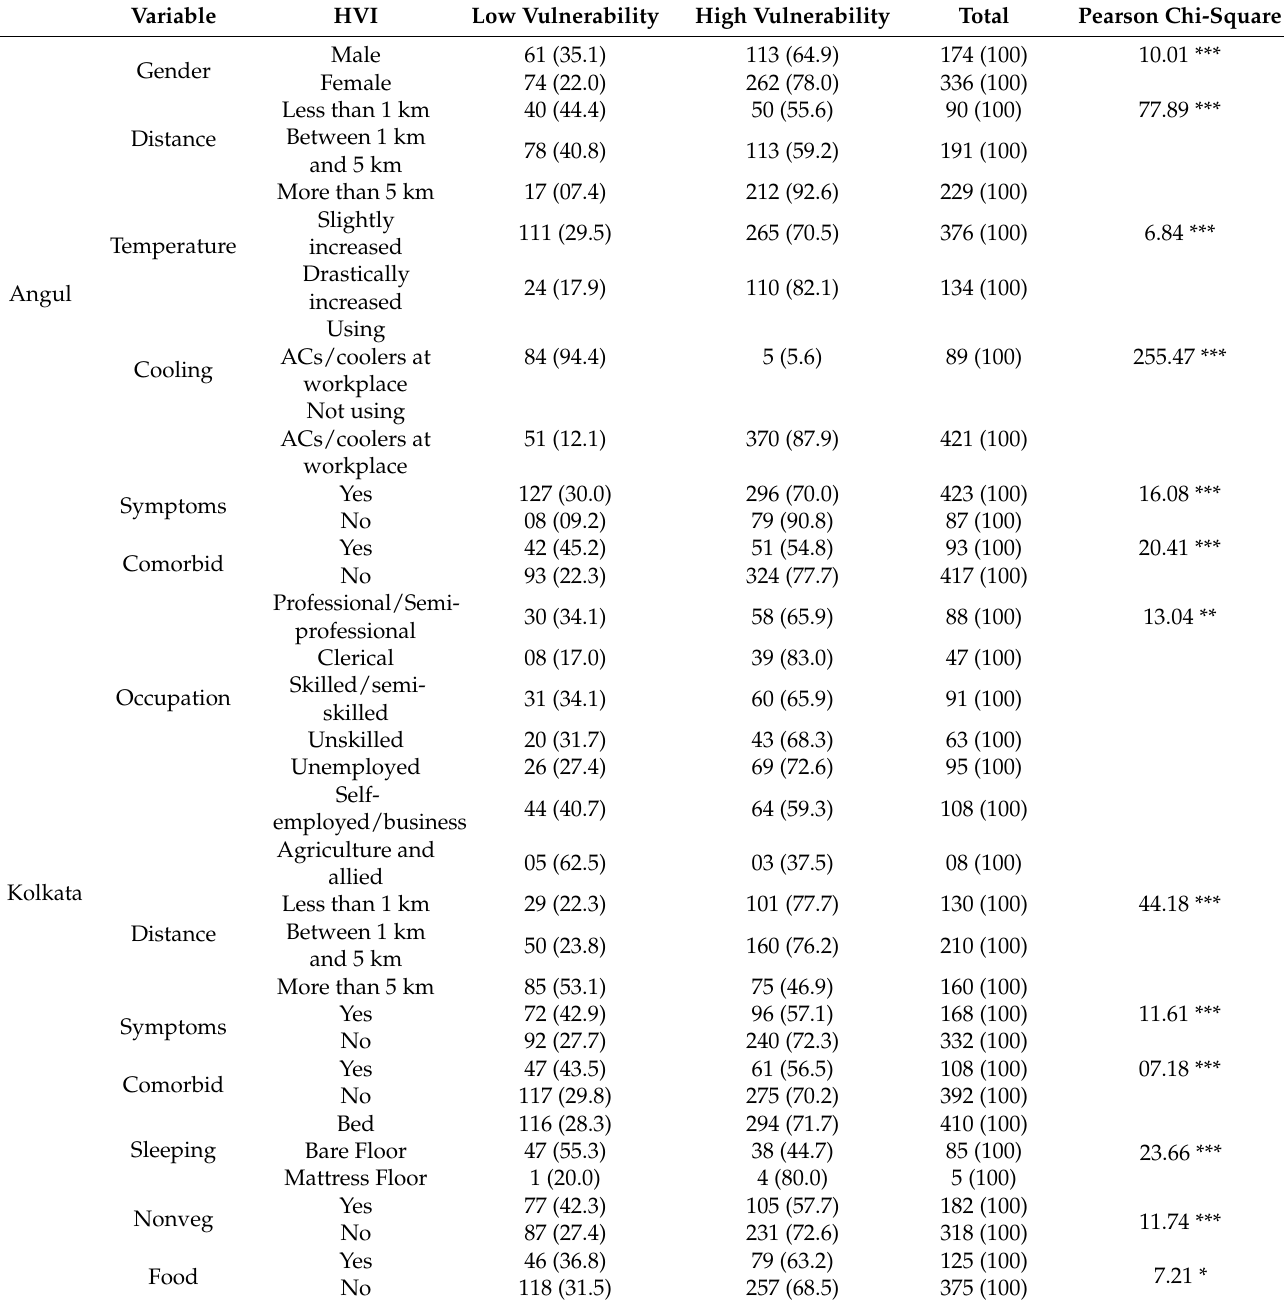
Table 2. Crosstabulation of HVI with independent variables (Angul and